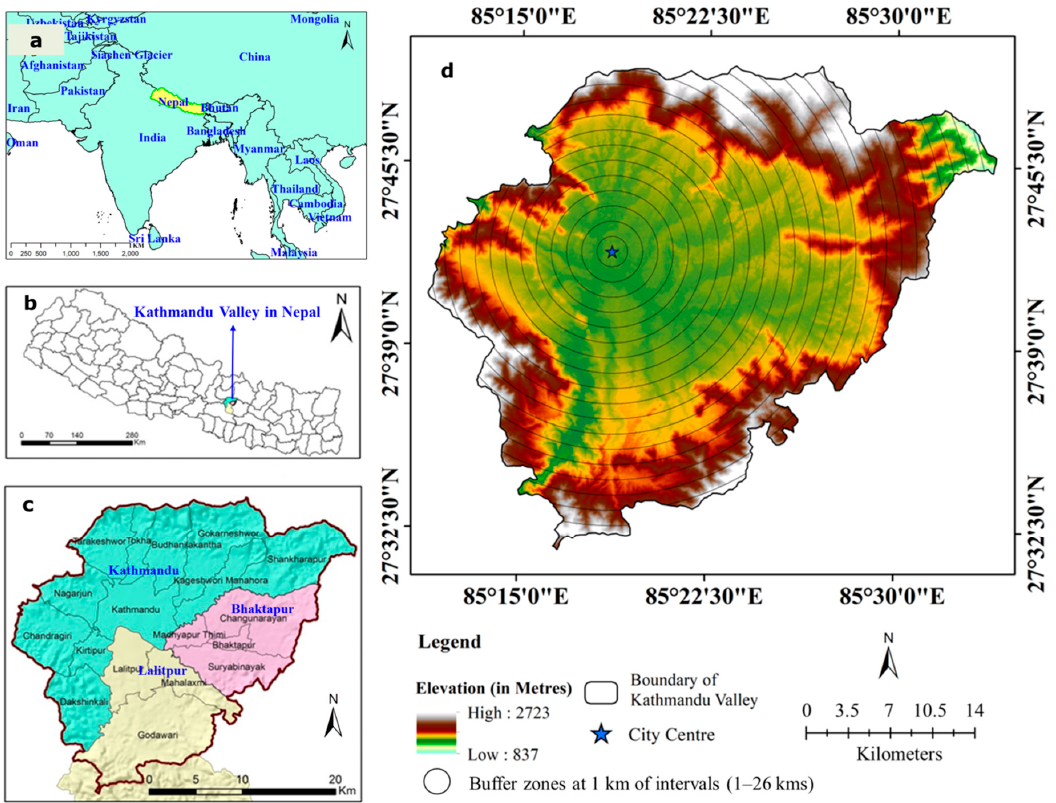
Figure 1. Location of the study area; ( a ) Nepal; ( b ) District boundaries of Nepal dated 2018; ( c ) Kathmandu Valley and its three districts of Bhaktapur, Kathmandu, and Lalitpur; ( d ) elevation of the study area (source: Global Digital Elevation Model data of ASTER of 2011 .